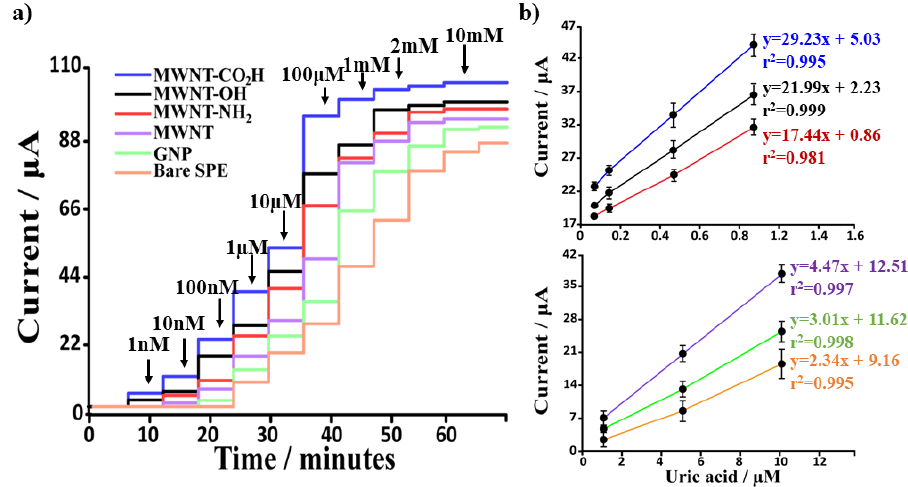
Figure 5. ( a ) Amperometric traces recorded, using a potential 0.05 V and the corresponding ( b ) calibration curves obtained using bare and nanomaterial-modified biosensor (GNP, Bare MWNT, MWNT-OH, MWNT-CO 2 H and MWNT-NH 2 ) in the presence of an increasing concentration of uric acid (addition method to have a concentration from 0.1 nM to10 mM). Table 3. LOD, sensitivity, and Km (Michaelis–Menten constant) estimation for bare and CNMs- modified biosensors. These analytical parameters were obtained from chronoamperometric traces (E, time interval and time run respectively equal to 0.05 V, 0.01 s, and 300.0 s). Bare